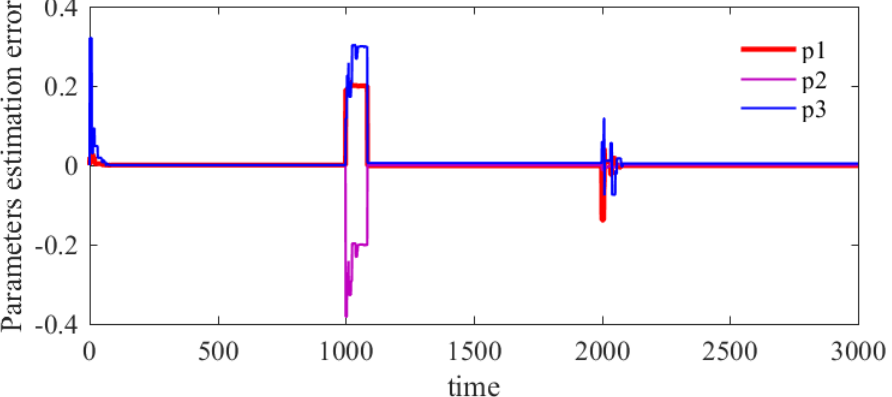
Figure 5. Euclide distance based parameters estimation error (noise